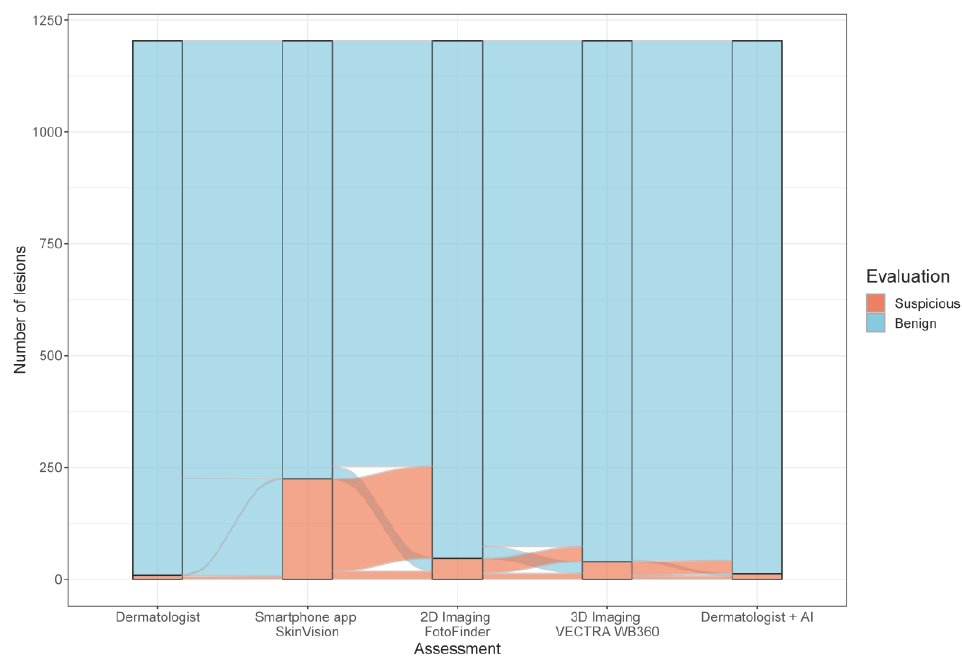
Figure 2. Comparison of risk assessments with the highest rate of suspected melanoma cases by the smartphone app (n = 1204).